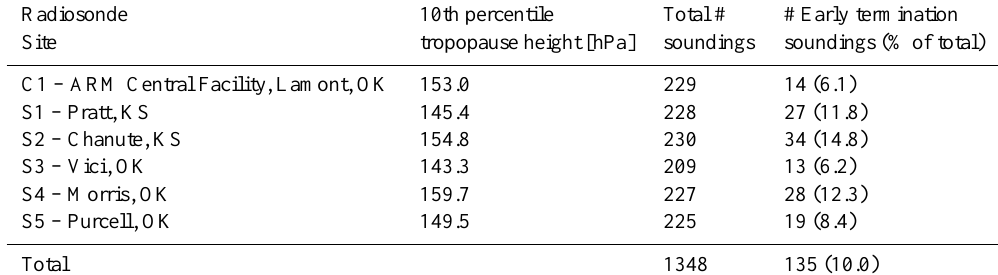
Table 2. Summary of termination height of MC3E soundings. 10th percentile tropopause height is taken from Rapid Update Cycle (RUC) analysis for period from 22 April through 6 June 2011. Early termination indicates soundings that did not sample above the 10th percentile tropopause height. The total sounding number here does not include the 14 sondes that were not correctable (see text for additional